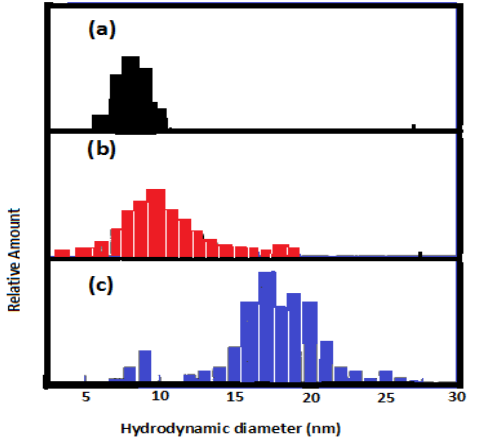
Figure 7. Particle size distribution of Ag/PVA-SH in 1 M HCl and 0.4 M of glycine at interval times ( a ) 1 h, ( b ) 24 h and ( c ) 7